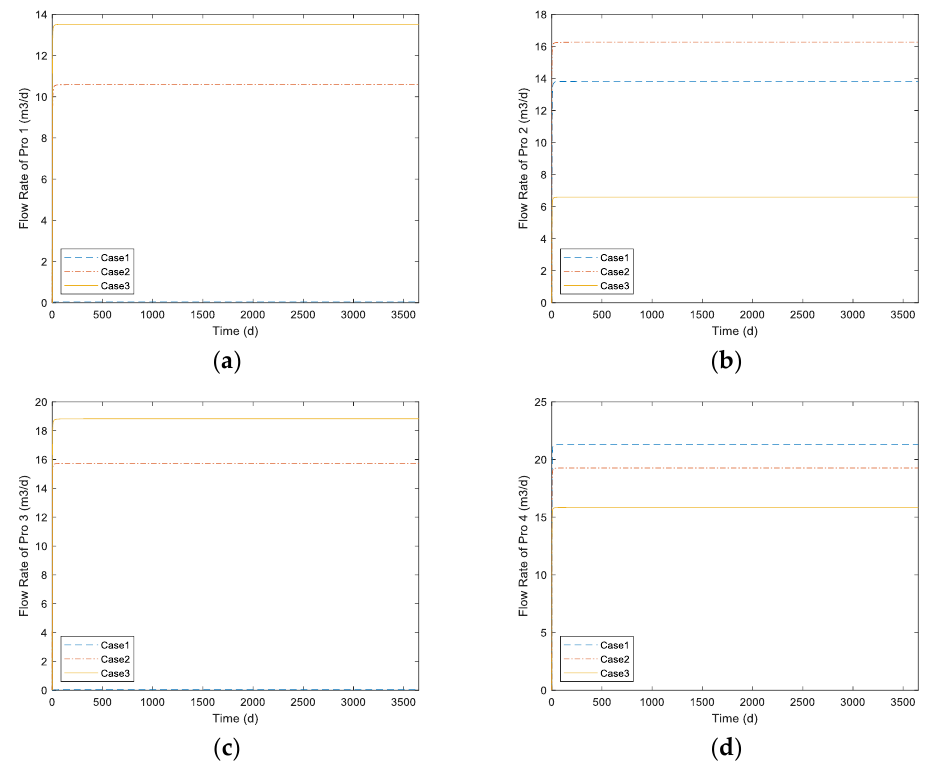
Figure 17. The flow rate of the production well ( a ) Pro1 ( b ) Pro2 ( c ) Pro3 ( d ) Pro4.